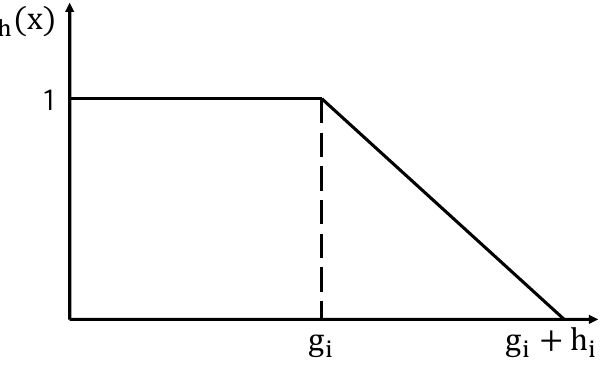
Figure 2. Linear membership function for i th goal.